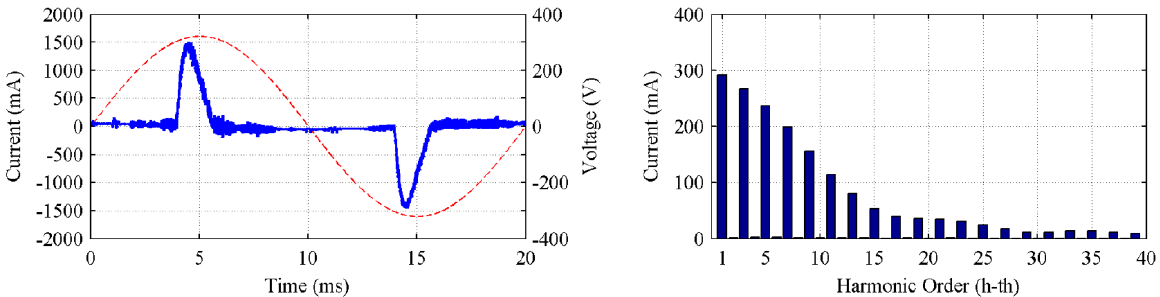
Figure 4. LED panel of 49.5 W without dimming: current waveform and its harmonic